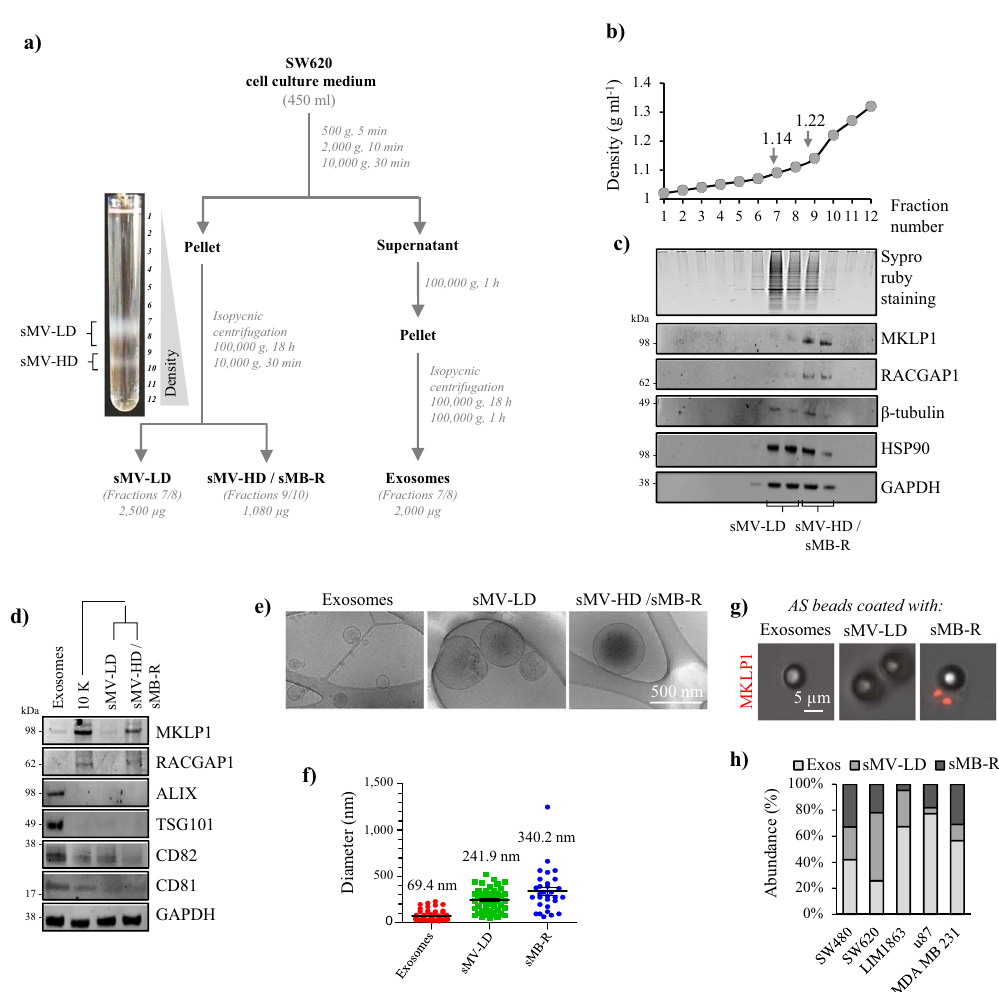
Fig. 2 Isolation and characterisation of shed midbody remnants (sMB-Rs). a Experimental work fl ow for puri fi cation of sMB-Rs from SW620 cell culture medium (CM). CM was subjected to differential centrifugation to obtain crude sMVs (10,000 × g pellet) and exosomes (100,000 × g pellet) that were further fractionated using isopycnic density gradient centrifugation. Photographic image shows that crude sMVs (10,000 × g pellet) fl oated in two major fractions: low-density fractions 7/8 (sMV-LD) and high-density fractions 9/10 (sMV-HD/sMB-Rs). b The buoyant densities of twelve 1-mL fractions collected for each preparation were determined by absorbance at 244nm using a molar extinction coef fi cient of 320 L g − 1 cm − 1 . c SDS-PAGE of 12 OptiPrep ™ fractions. Protein quantitation was determined by SYPRO Ruby staining and western blot analysis performed using indicated antibodies. d Western blot analysis of SW620 cell-derived Exos, 10,000 × g EVs (crude sMVs), sMV-LD (fractions 7-8) and sMB-R (sMV-HD) (fractions 9-10) using indicated antibodies ( n = 2 biological replicates). e Cryo-electron microscopic analysis of SW620 cell-derived Exos, sMV-LD and sMB-Rs. f Histogram represents the measurements of diameter of Exos, sMV-LD and sMB-R based on cryo-EM images. Data presented as mean ± s.e.m (standard error of mean). g Fluorescence microscopic analysis of Exos, sMVs-LD and sMB-Rs derived from SW620-GAP-GFP cells loaded onto aldehyde sulfate (AS) latex beads and immunostained with anti-MKLP1 antibodies (in red). h Bar plot showing protein yield (based on SYPRO Ruby protein quantitation) of